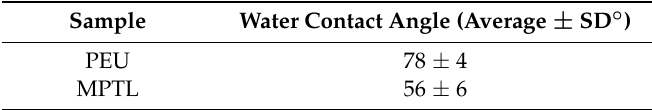
Table 3. Water contact angle of native PUR and MPTL scaffold